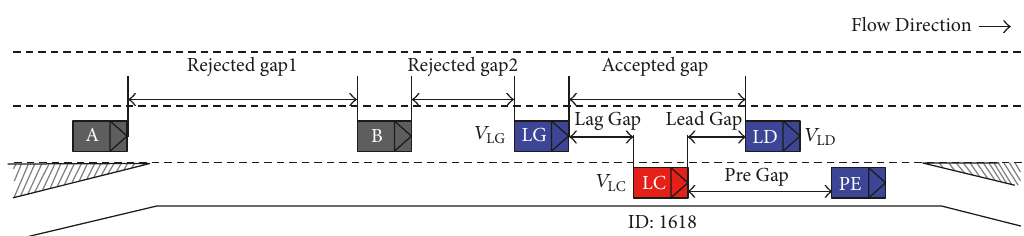
Figure 2: Description of the variables in a merging process , where LC is the merging vehicle, LD is the leading vehicle on the target lane, LG is the following vehicle on the target lane, and PE is the leading vehicle on the initial